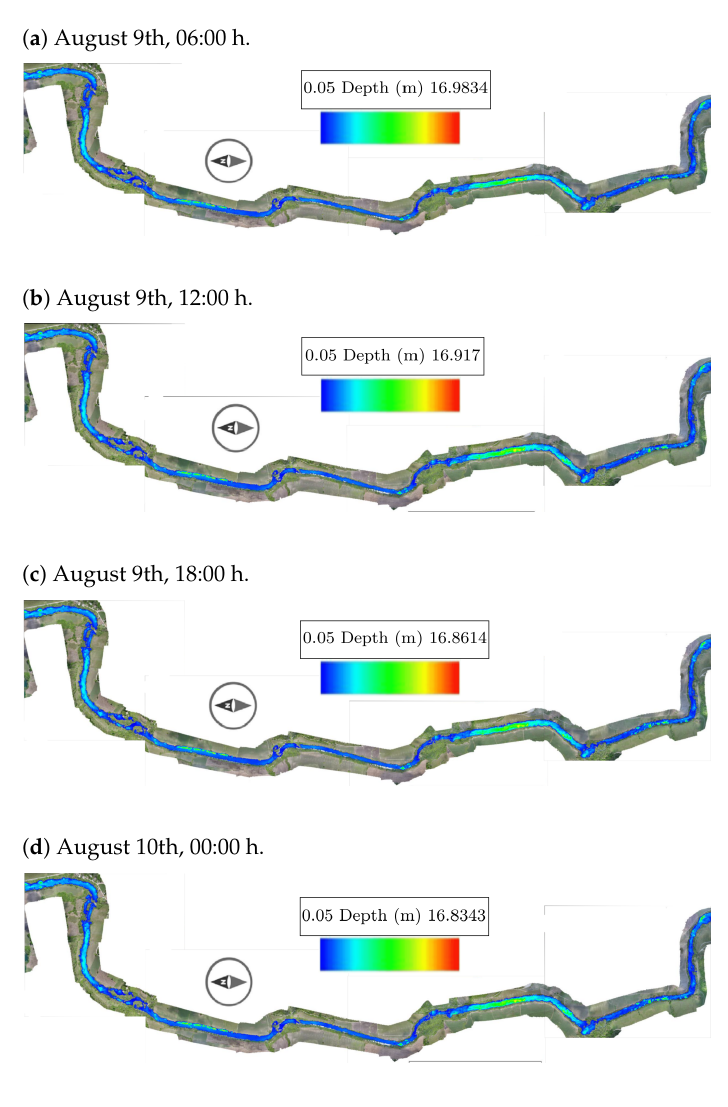
Figure 18. Depths for scenario 4.